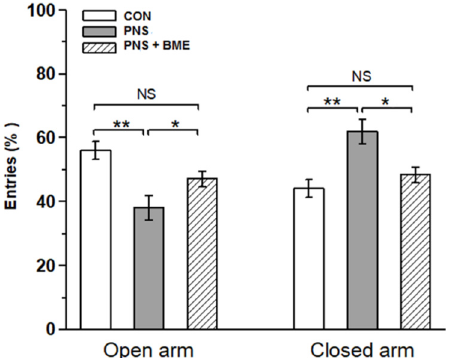
Figure 2. E ff ect of exposure to BME treatment on PNS-induced changes in o ff spring. Behavioral profile of EPM showed as the percentage of entries in the open arm and closed arm, maternal exposure to BME treatment and resilience e ff ect on the anxiety-like behavior in the o ff spring. Data are expressed in percentage (mean ± SEM) calculated against the total number of entries (control n = 7, PNS n = 6, PNS + BME n = 6). One-way ANOVA followed by Bonferroni post hoc test (for all pairwise multiple comparisons, statistical significance is indicated by * p < 0.05 and ** p < 0.01; NS—Not